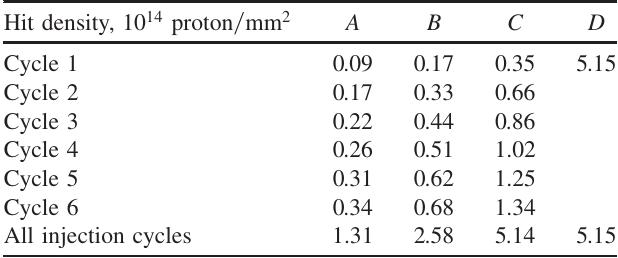
TABLE V. Calculated hit density on a foil at the hottest spot for various injection cycles and for painting injection scenarios A through D (see Table II).